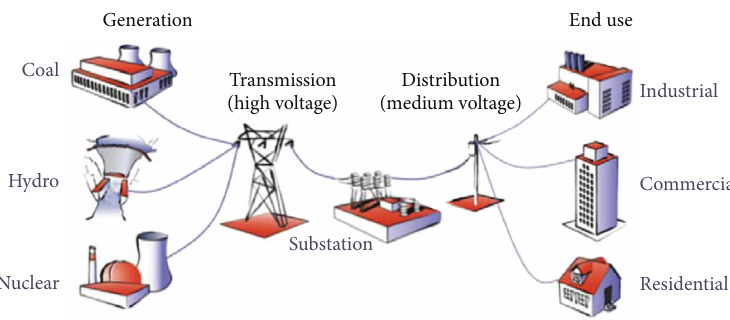
Figure 2: Elements of electrical power grid.